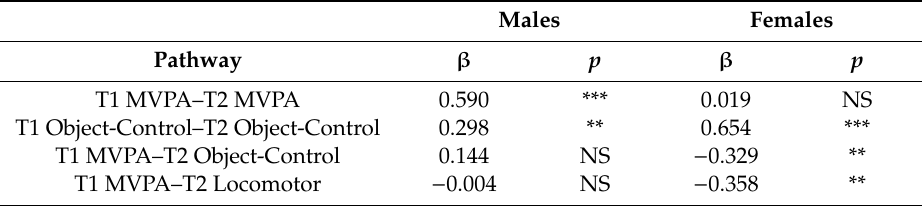
Table 5. Pathways by sex.